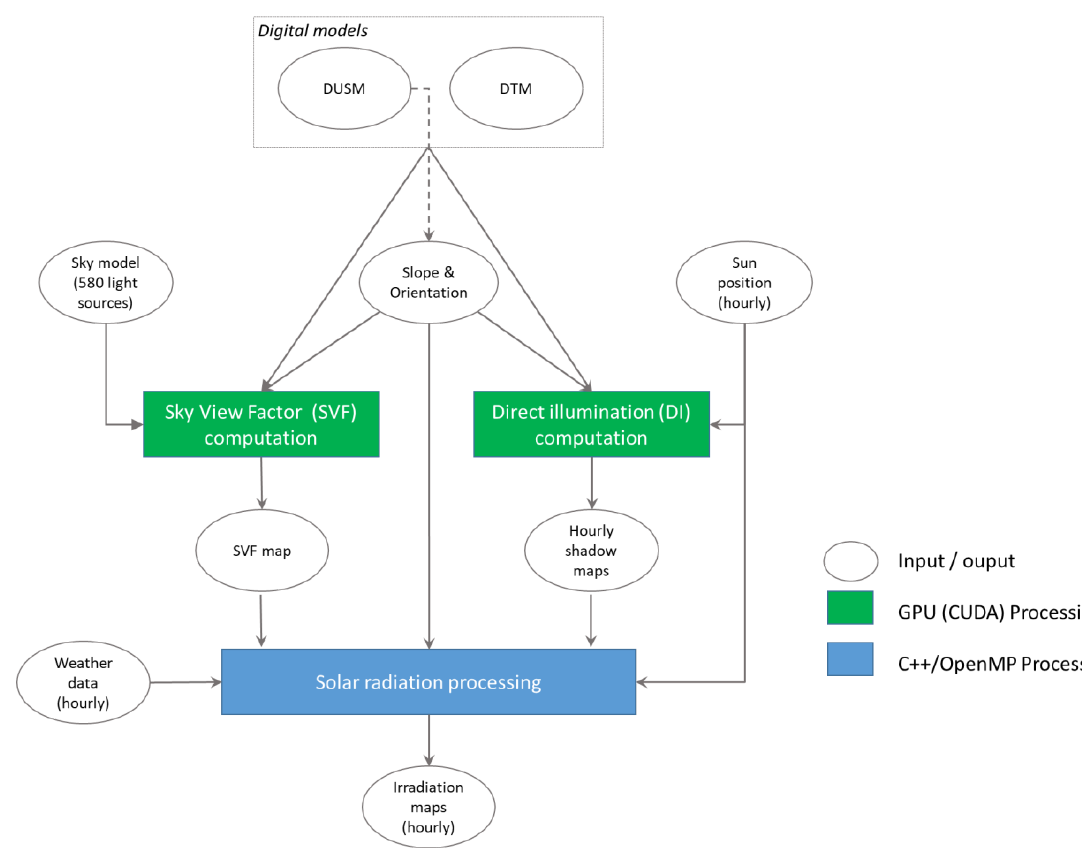
Figure 3. A schematic view of the processing pipeline for a tile, detailing the image processing step of Figure 1. DTM: Digital Terrain Model; GPU: Graphics Processing Units; CUDA: Compute Unified Device Architecture.